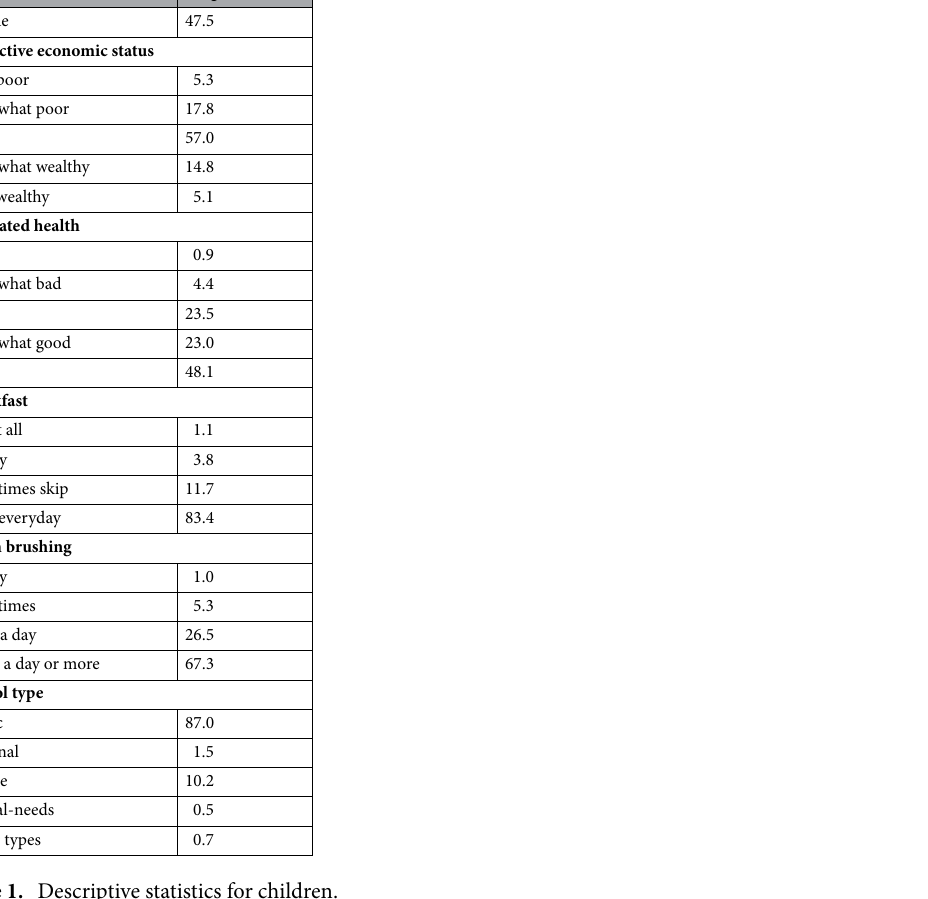
Table 1. Descriptive statistics for